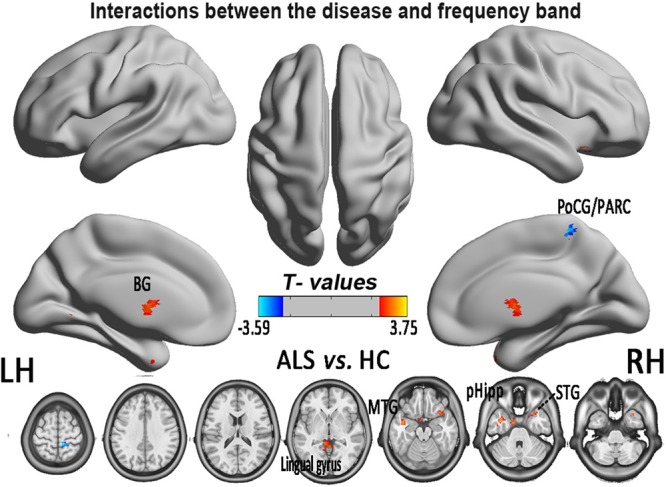
The interaction between the frequency band and the diseased FCS. The alterations indicated the interaction between the frequency bands (slow-4 and slow-5) and the groups of ALS patients and HCs, based on the two-way ANOVA (double-factor), with Gaussian random field correction, the voxel level of P < 0.05 and the cluster level of P < 0.05 were considered to be statistically significant. The cool color indicates the brain regions of the decreased FCS, and the warm color indicates the brain regions of the increased FCS on the comparison between ALS and HCs groups. CAL, cerebellum anterior lobe.